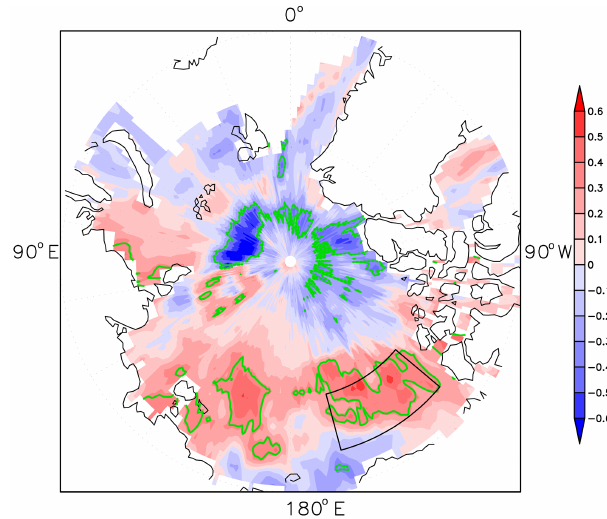
Figure 8. The CC between WHD NCP DY and ASI DY in autumn from 1980 to 2013. The shades indicate that the CC exceeded the 95% confidence level, and the box represents the selected region (73–78 ◦ N, 130–165 ◦ W) of predictor x 4 .